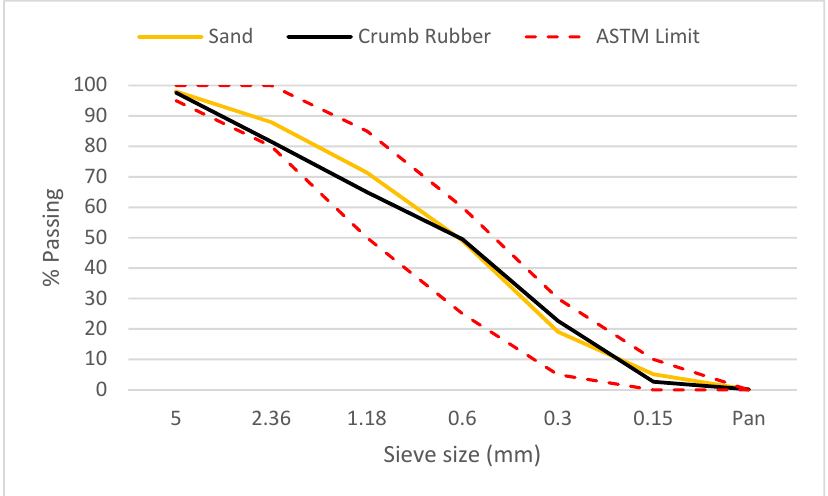
Figure 1. Grading curves for sand and crumb rubber aggregates.